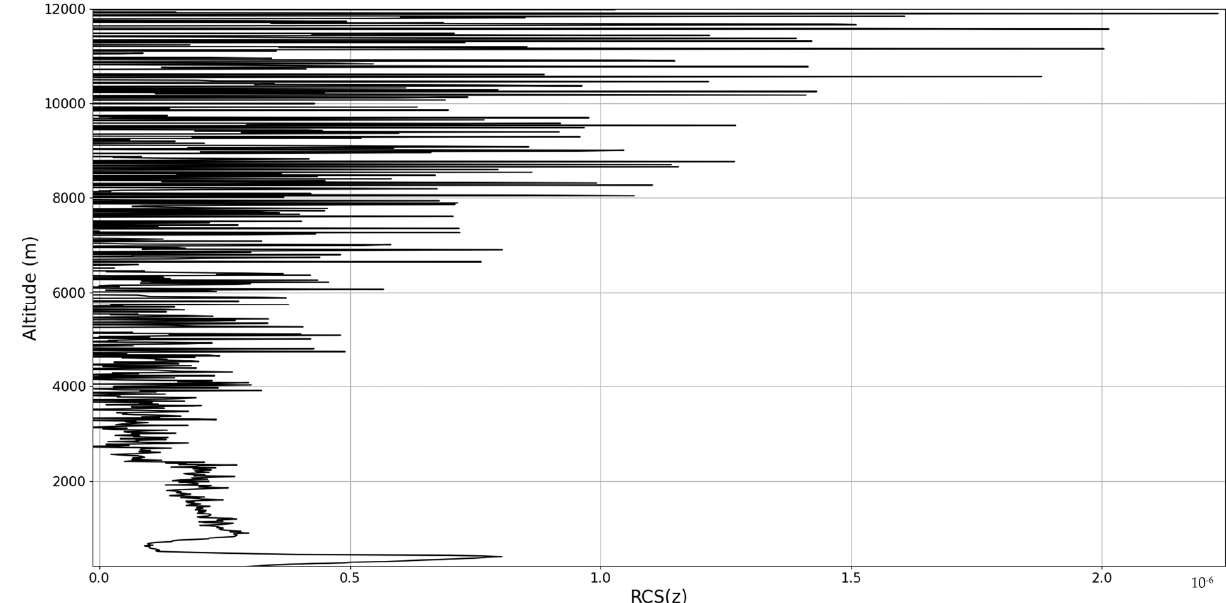
Figure 9. RCS vertical profile, λ = 1064 nm , Gala ț i, Romania, 22 December 2021.